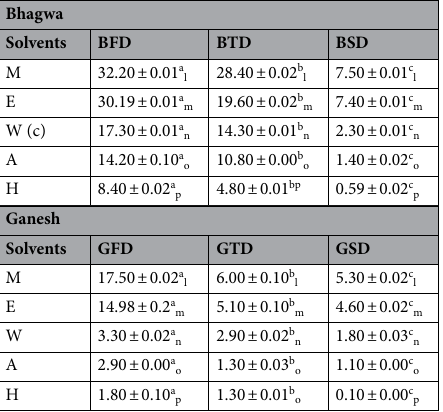
Table 3. Quantification of ellagic acid (mg/g) from pomegranate peel. Mean ± SD n = 3, a, b, c represents a statistically significant difference between drying methods in row wise manner for specific solvent whereas l, m, n, o, p, q refers to statistically significant difference among solvents for respective drying method (column wise); BFD Bhagwa freeze-dried, BTD Bhagwa tray-dried, BSD Bhagwa sun-dried, GFD Ganesh